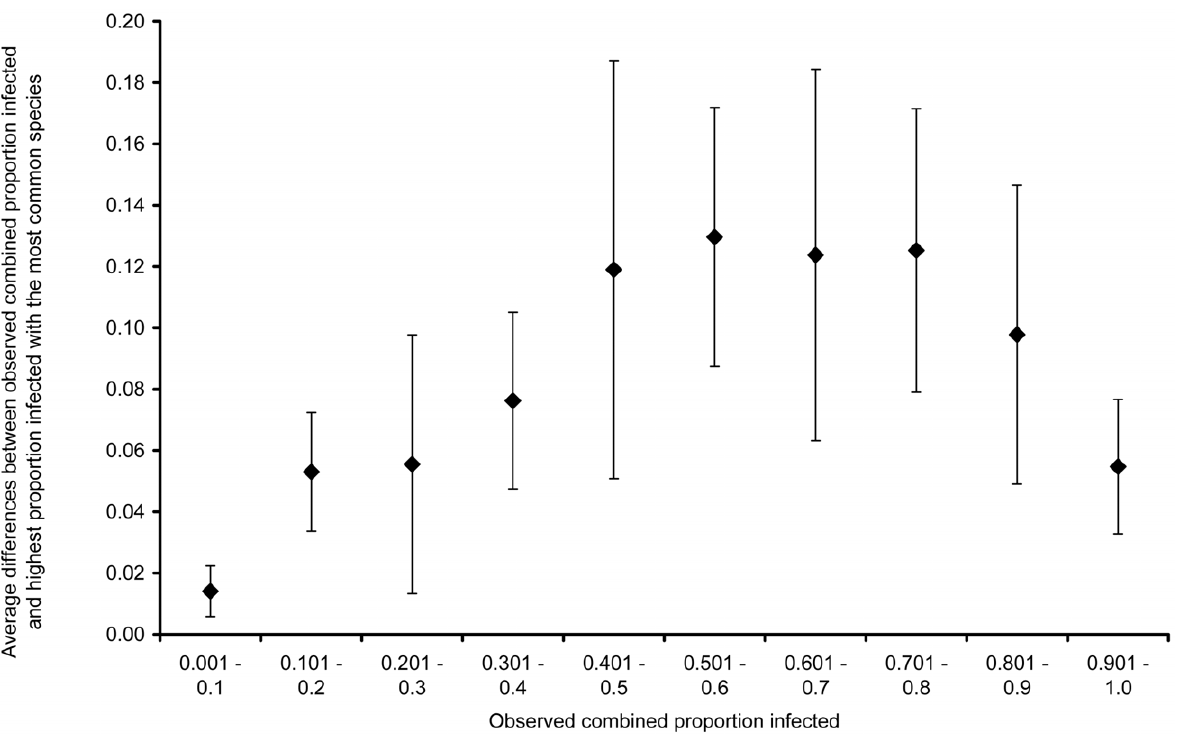
Figure 5. A plot of the average difference between the observed combined proportion infected and the proportion infected with the most common species for ten centiles of combined proportions infected in 63 surveys, with 95% confidence